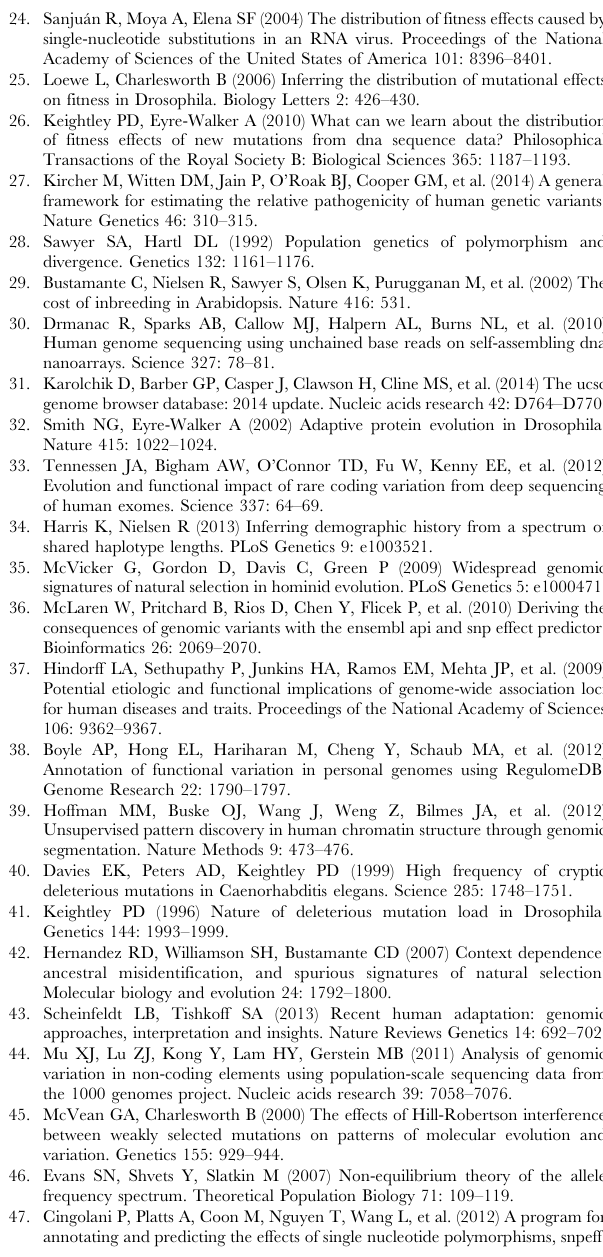
Figure S16 Comparison of reference/alternative bias observed in C-scores and human-free conservation scores. For each score, we computed the absolute difference in means of scores at sites where reference = ancestral and at sites where reference = derived, divided by the total standard deviation at both types of sites, and plotted as a function of the number of derived alleles. The size of each circle denotes the proportion of sites where alternative =an- cestral at each derived allele bin. Table S1 Characteristics of fitness effect distributions estimated for YRI SNPs classified by different genomic consequence categories, RegulomeDB categories and Segway categories, using the exome-wide C-to-s mapping. We show quantiles of selection coefficients, the log base 10 of the mean selection coefficient and